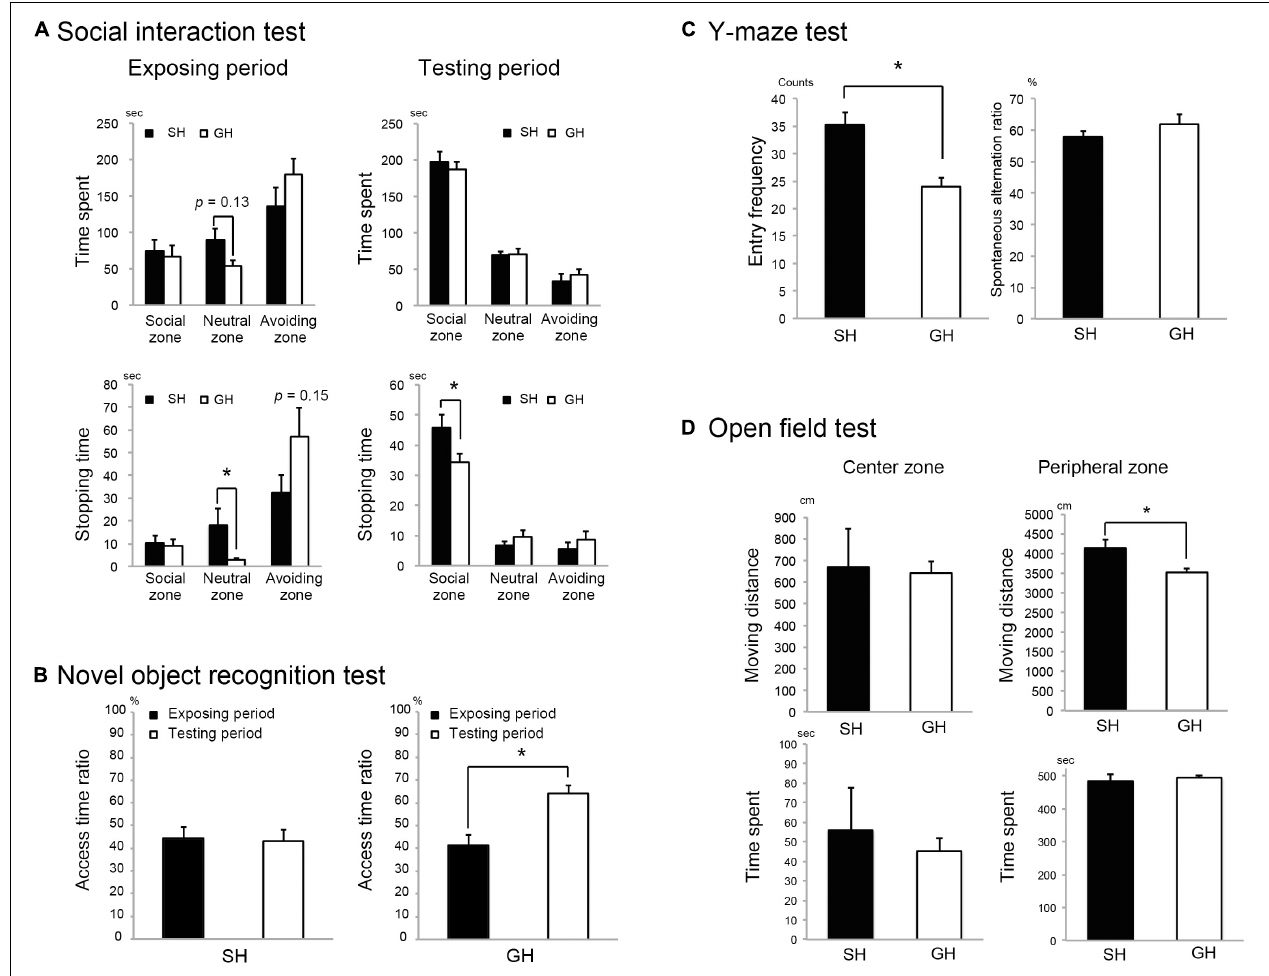
FIGURE 2 | Effect of housing condition on mice behavior. (A) Single housing (SH) mice stopped longer in the neutral zone and in the social zone ( Supplementary Figure 1A ) than group housing (GH) mice during the exposure and the testing period, respectively ( n = 10 for each group). (B) SH group mice showed less interest to access the novel object than GH mice ( n = 7 for each group). (C) SH mice showed a larger arm entry frequency than GH mice in the Y-maze test ( n = 10 for each group). (D) SH mice moved significantly longer distance than the GH mice ( n = 10 for each group) in the peripheral zone of the open field ( Supplementary Figure 1E ). Values are mean ± SEM. *Significant difference detected by Kruskal-Wallis test ( p <